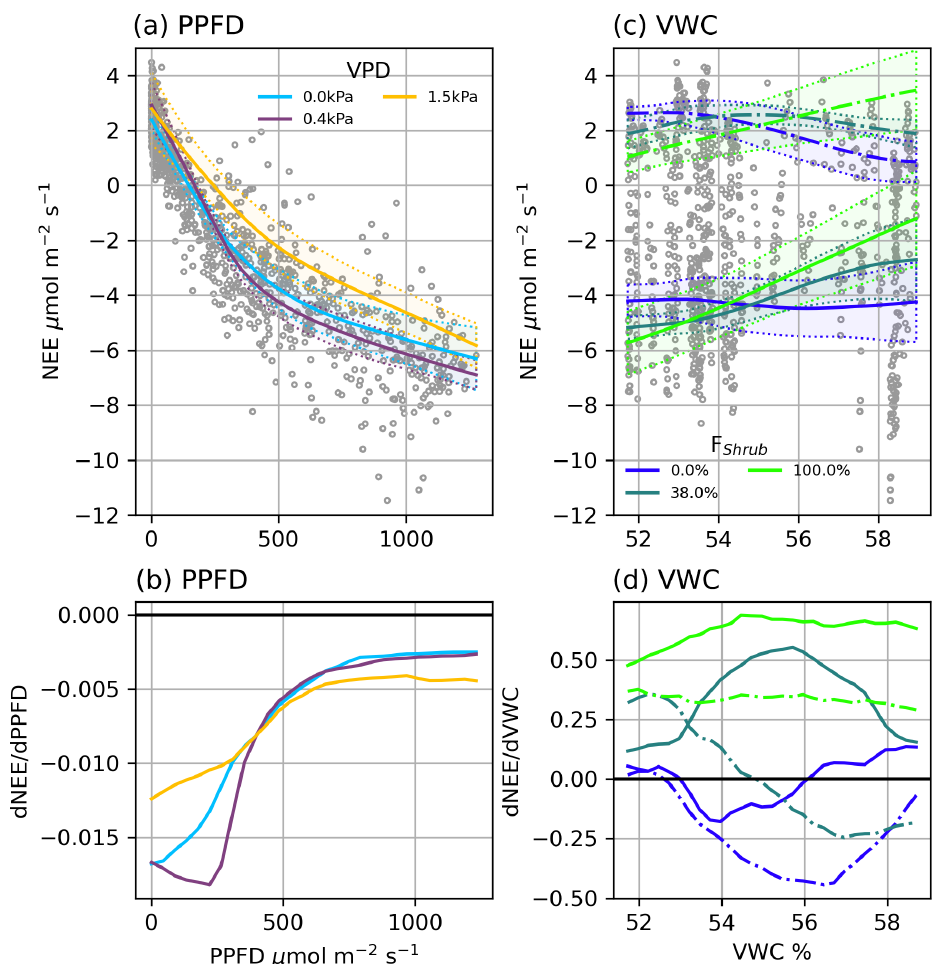
Figure 4. (a) Modelled NEE response to PPFD under different VPD conditions and (b) the partial first derivatives of NEE with respect to PPFD. (c) Modelled ER (dashed line) and NEE (solid line) response to VWC at different Shrub % values and (d) the partial first derivatives of ER (dashed lined) and NEE (solid line) with respect to VWC. NEE in (c) was calculated at PPFD = 600µmolm 2 s − 1 . The shaded areas in (a) and (c) are 95% confidence intervals and grey circles are the EC